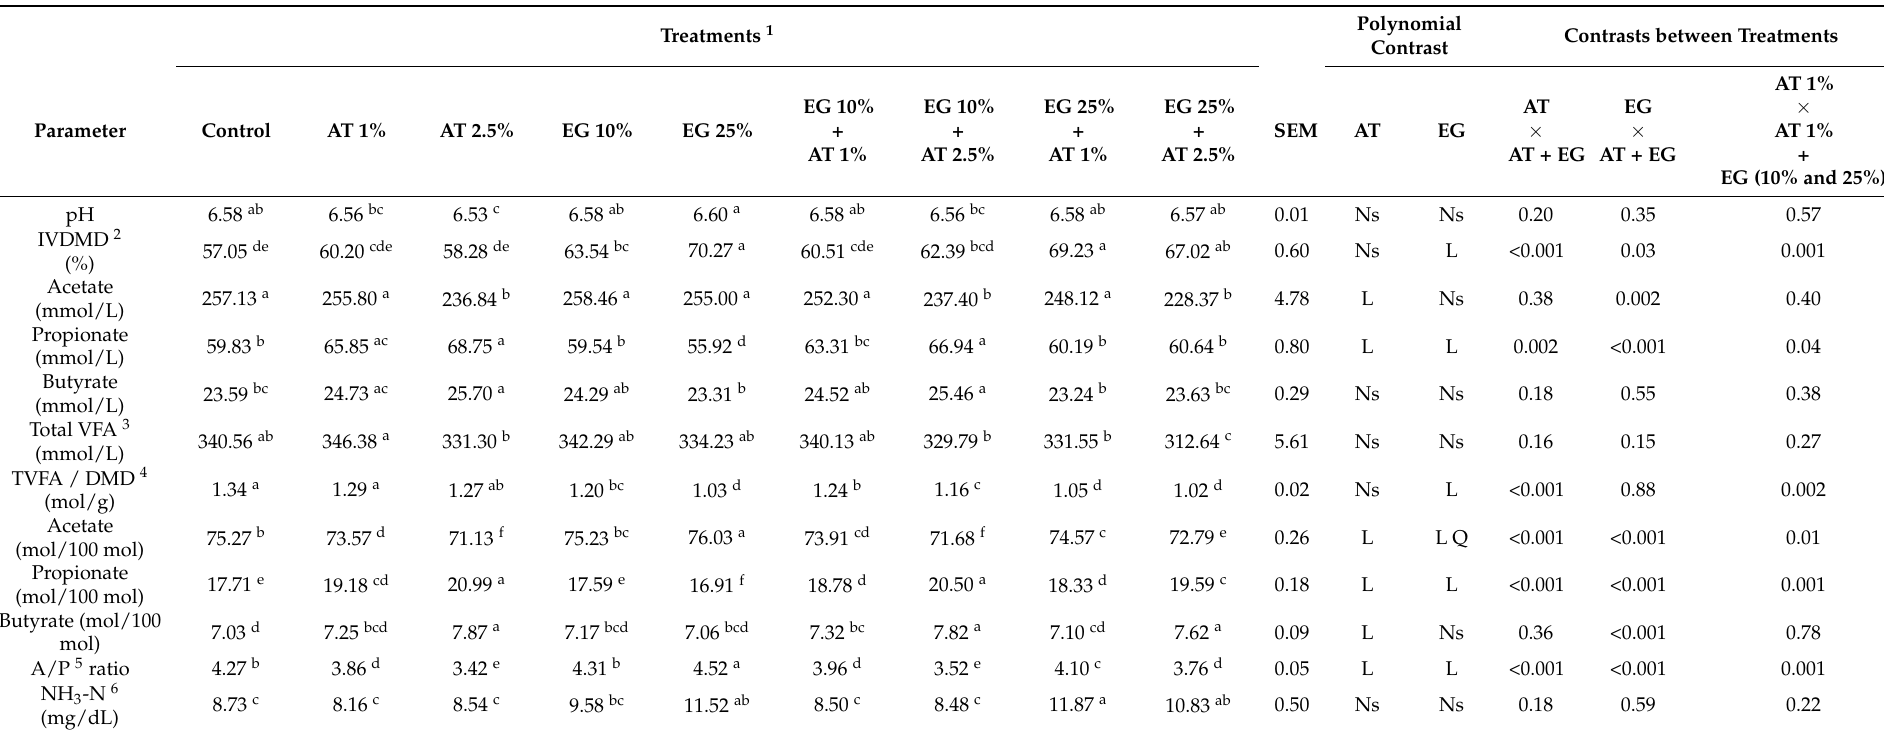
Table 6. Effect of Euglena , Asparagopsis , and their combination on ruminal fermentation characteristics from 24 h in vitro incubation (n =